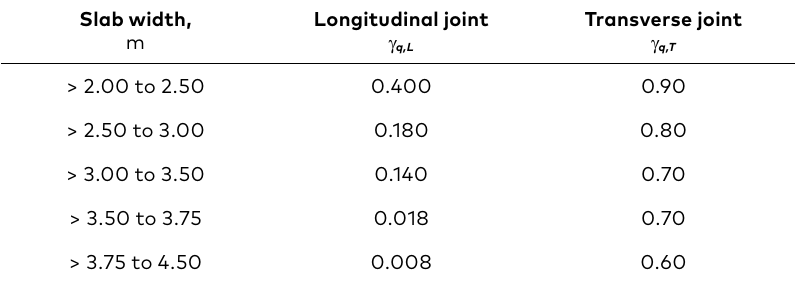
Table 6. Load transfer factors g